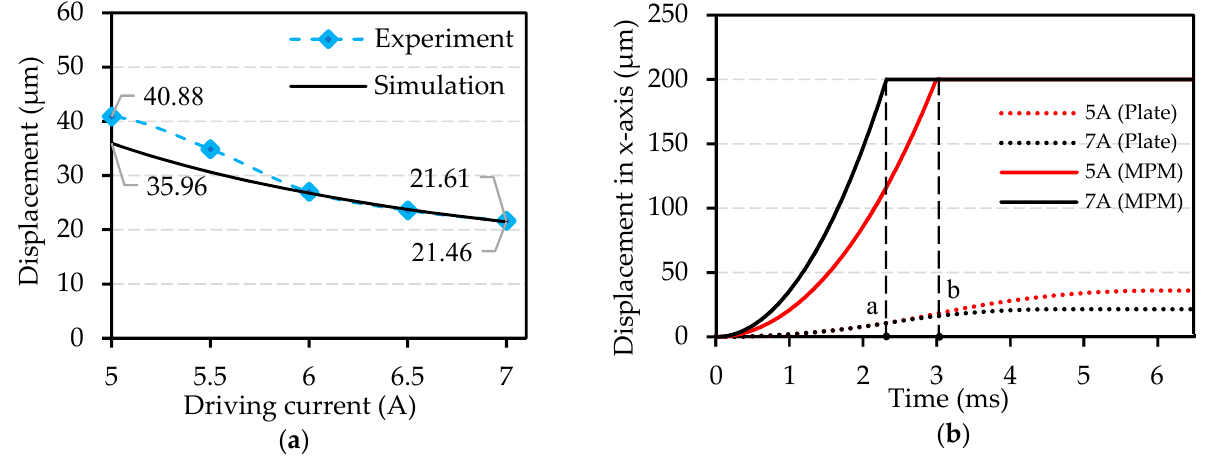
Figure 9. ( a ) Influence of driving current on the conveyed plate SSD. ( b ) Simulation of plate and MPM displacement during one switch.